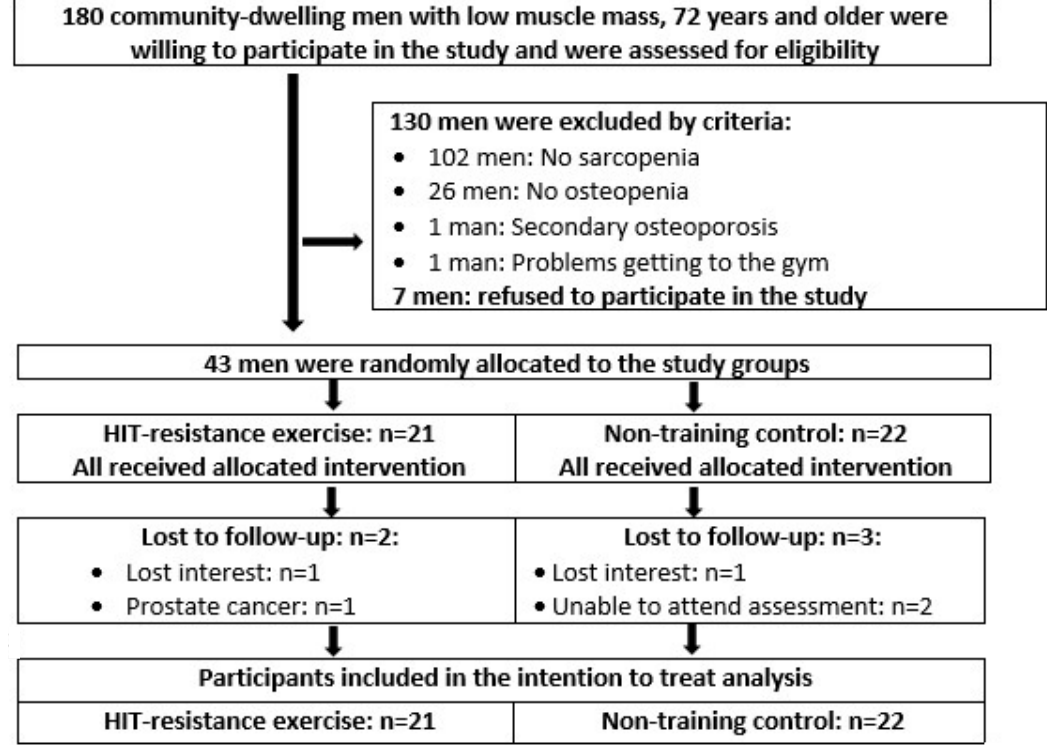
Figure 1. Participant flow through the study. HIT: High intensity training.